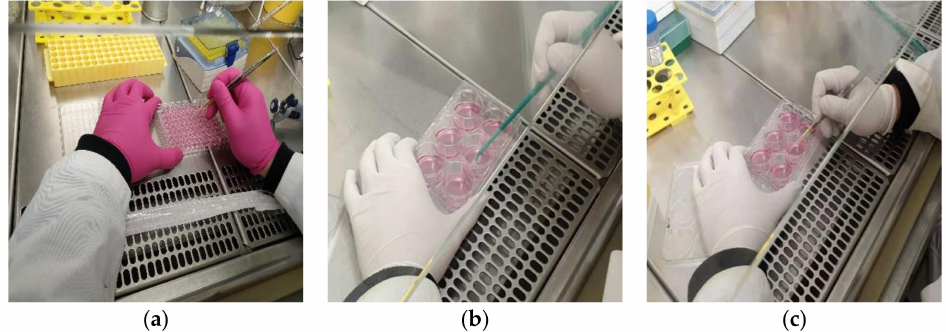
Figure 12. Uninteresting cells eliminate with tips and scraper. Use cell scraper to eliminate the cells at distant location from the marked clone. After that, eliminate the cells that closely surround the marked clone and on the edge of the well carefully by using the pipette tips. ( a ) Cell elimination by using tips in 96-well plate well. ( b ) Cell elimination by using cell scraper in 6-well plate well. ( c ) Cell elimination by using tips in 6-well plate well.